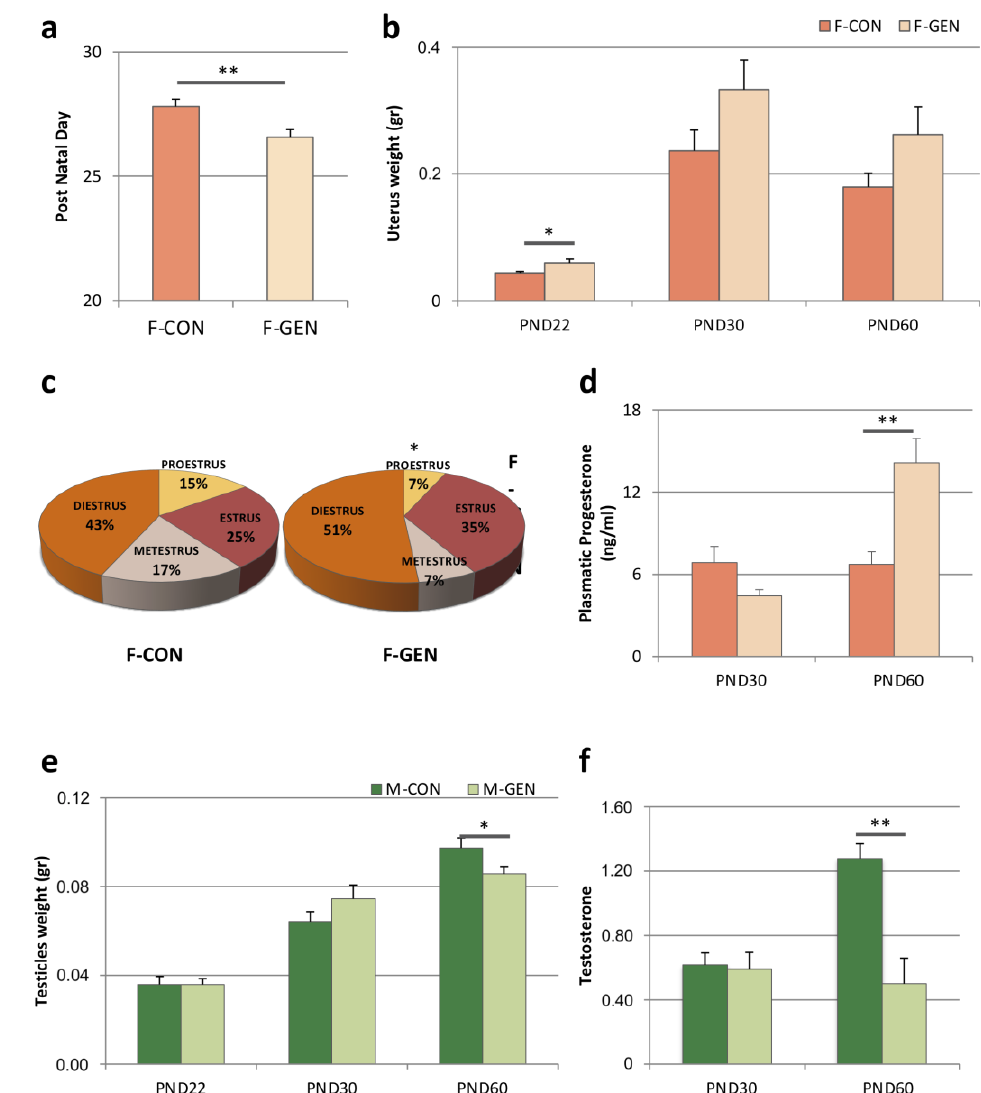
Figure 1. Parameters related to reproduction. ( a ) Histograms representing the evaluation of the day of vaginal opening (VO) in control (F-CON) and treated (F-GEN) female CD1 mice (mean ± SEM). ( b ) Histograms representing the variations of the uterus weight (expressed in gram; mean ± SEM) measured during development at postnatal day (PND) 22, PND30, and PND60 of control (F-CON) and treated (F-GEN) females. ( c ) Pie charts illustrating the time spent (expressed as percentage) in each phase of estrus cycle (estrus, metestrus, diestrus, and proestrus) in control (F-CON) and treated (F-GEN) females. ( d ) Histograms representing circulating variations of plasma concentration of progesterone (expressed in ng/mL, mean ± SEM) in control (F-CON) and treated (F-GEN) females, during development at PND30 and PND60. ( e ) Histogram representing the increase of testicle weight (expressed in gram; mean ± SEM) measured during development at postnatal day (PND) 22, PND30, and PND60 of control (M-CON) and treated (M-GEN) males. ( f ) Histogram representing variations of fecal testosterone levels (expressed in ng/mL) in control (M-CON) and treated (F-GEN) males, during development at PND30 and PND60. * p < 0.05; ** p ≤ 0.01. VO, uterus and testicles weight, and time spent in each phase of estrus cycle were compared using Student’s t -test, while the progesterone was analyzed using Tukey ’s test.